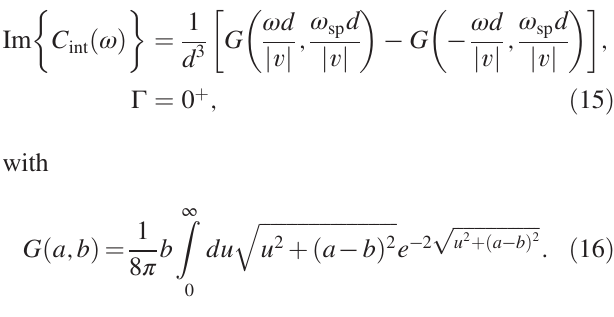
d= j v j Figure 2(c) shows Im f C g d 3 as a function of ω int sp for different values of ω . As seen, for sufficiently small d= j v j , the imaginary part of Im f C values of ω g d 3 can be sp int negative. The minimum value of Im f C g ≈ − 10 − 4 =d 3 int occurs at the frequency of oscillation ω ¼ ω (green solid sp line), i.e., at the surface plasmon resonance, and for ω d= j v j ≈ 0 . 19 . Thus, the optimal relative velocity is sp v ¼ 5 . 26 ω d . By decreasing the distance d between the sp dipole and the moving surface, the absolute value of Im f C , g < 0 can be made arbitrarily large. For ω ¼ ω int sp v ¼ 5 . 26 ω d and Γ ¼ 0 þ , the condition to have over- sp =c Þ 3 þ compensation of the radiation loss is − 1 = 6 π ð ω sp 10 − 4 =d 3 > 0 , and this yields ω d=c < 0 . 12 . For silver sp films, this condition imposes that d < 8 . 9 nm, but for